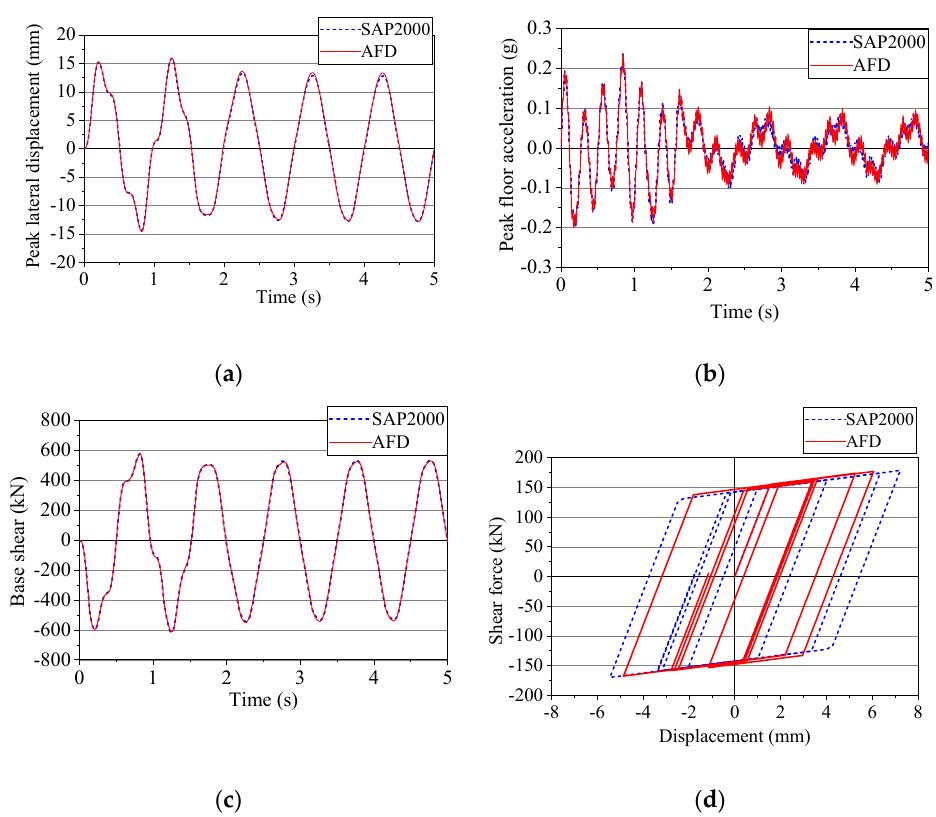
Figure 14. Responses of the frame under harmonic load P(t) with the period of sine wave of 1.0 (s): ( a ) Peak lateral displacement; ( b ) Peak floor acceleration; ( c ) Base shear; ( d ) Hysteretic curve of energy dissipation device.